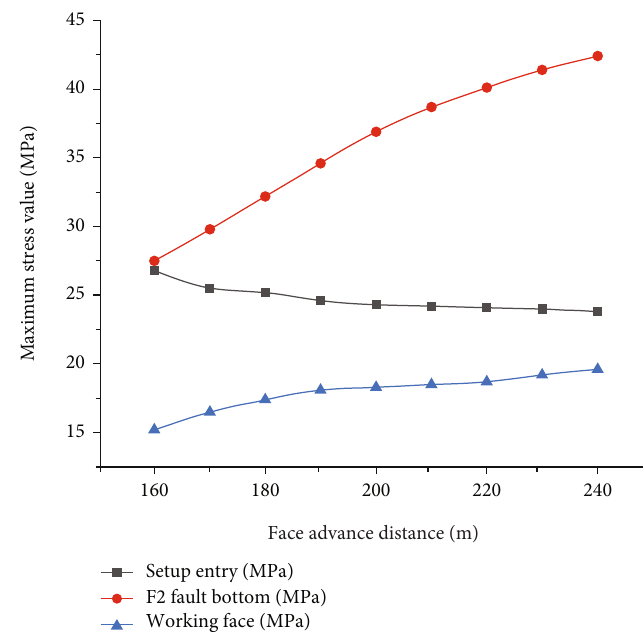
Figure 10: Vertical stress